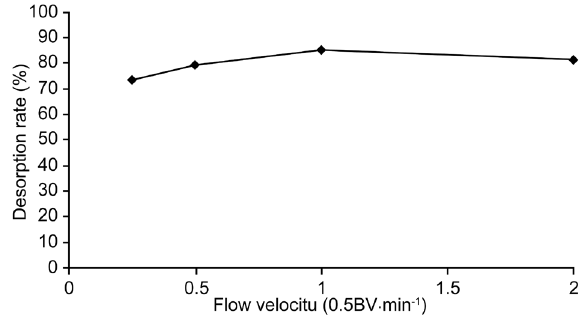
Table 1: Factors and levels of central composite design.